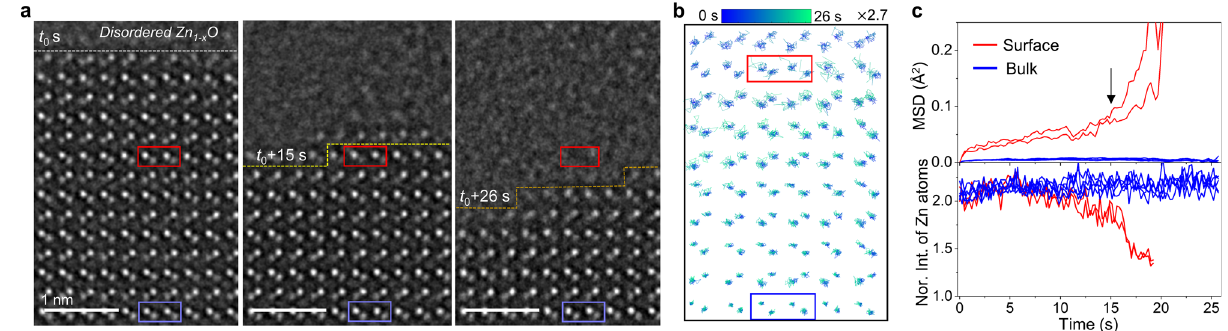
Fig. 5 | Atomic-scale disordering process during evaporation. a Time-series NCSI-HRTEM snapshot images of the (0001) surface during evaporation at 300°C (Supplementary Movie 5). The interface between the quasi-liquid layer and crys- talline Zn 1- x O is marked and two regions representing the V Zn -induced disordering (red box)and ordinarythermalvibration(blue box)arede fi ned. b Trajectoryof Zn and O atomic columns traced for the time span of 26s. The trajectory visualizes relatively larger displacements of Zn and O columns in crystalline Zn 1- x O (red box) compared with those in the blue box. c , MSDmeasured forthe Znatomiccolumns